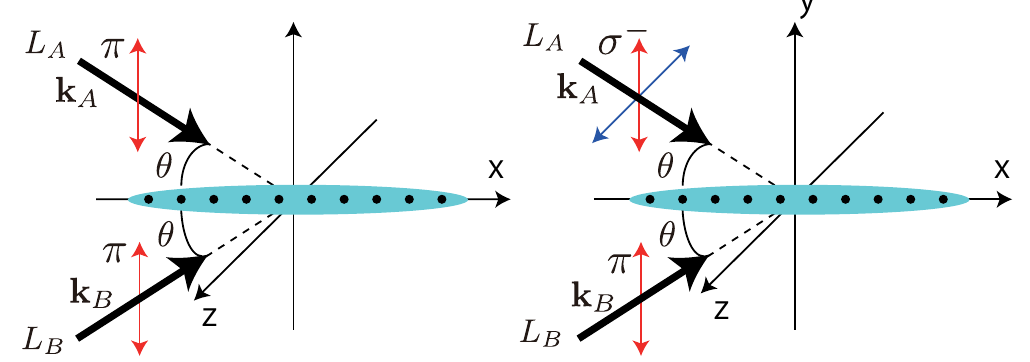
Figure 8. Schematics of the incident lasers for laser-assisted hopping. The quantization axis is in the x - phase along the x -direction, even though the value of the uniform phase of each tube is different. Figure 8 shows schematics of incident lasers for the laser-assisted hopping with the uniform phase. The blue ellipses represent a 1D gas trapped in two parallel optical lattice. The left panel shows two types of laser-assisted hopping, Λ bb jj Λ . Similarly, the right panel shows two types of laser-assisted hopping, Λ + 1 hopping with the uniform phase along the x -direction.